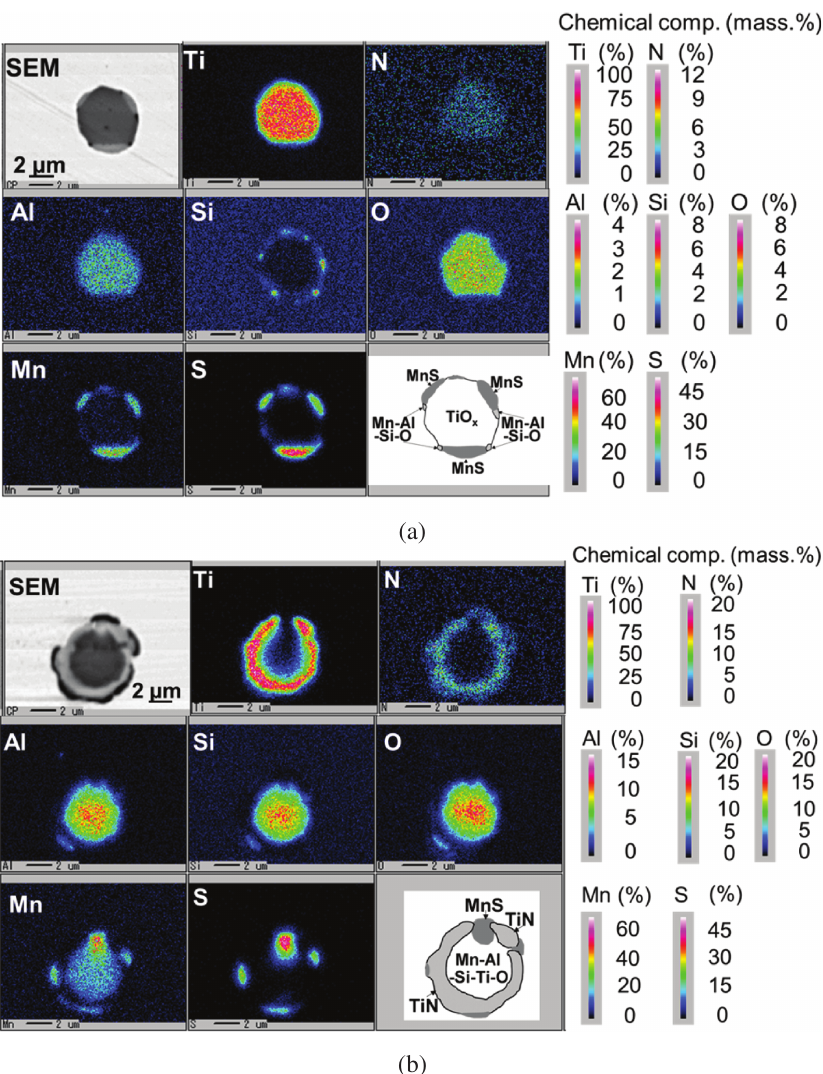
Figure 7: Element maps of Ti, N, Al, Si, O, Mn and S in inclusions of (a) steel with Ti 2 O 3 addition and (b) steel with TiN addition, determined by EPMA